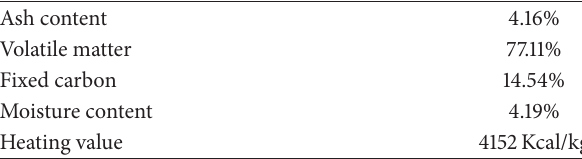
Table 2: Chemical characteristics of sesame stalk.